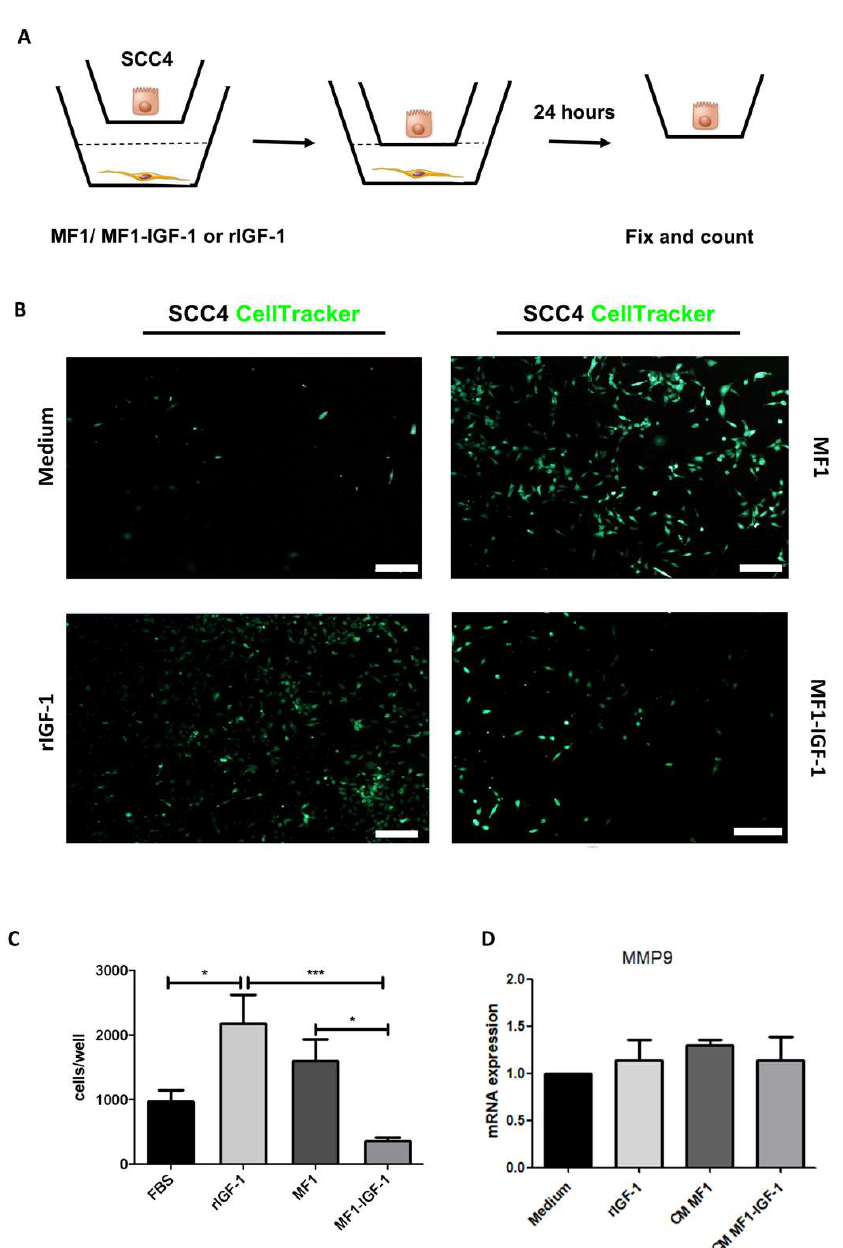
Figure 7. SCC-4 tumor cell invasion assay. ( A ) The invasiveness of SCC-4 cells was investigated by the Transwell assay, as represented by the schematic figure detailing experimental methodology. ( B ) CellTracker Green-stained SCC-4 cells are seen in the lower chamber at 24 h of incubation. Bars: 100 µ m. ( C ) Quantification of cells invading the matrix. Results from seven replicas, data presented as means ± SDs, bars represent comparisons between respective groups, (*) denotes statistical significance after applying the one-way ANOVA and Dunnett’s post-test, p < 0.05 and (***) denotes statistical significance after applying the one-way ANOVA and Dunnett’s post-test, p < 0.01. ( D ) Quantification of matrix metalloproteinase 9 (MMP9) mRNA by RT-qPCR in SCC-4, 6 h after stimulation with rIGF-1, MF1-CM or MF1-IGF-1-CM. CM: conditioned